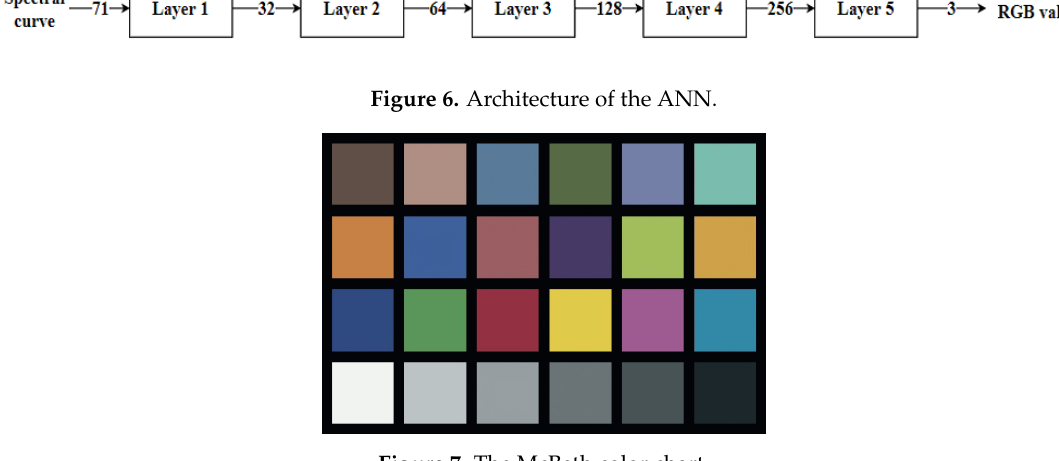
Figure 7. The McBeth color